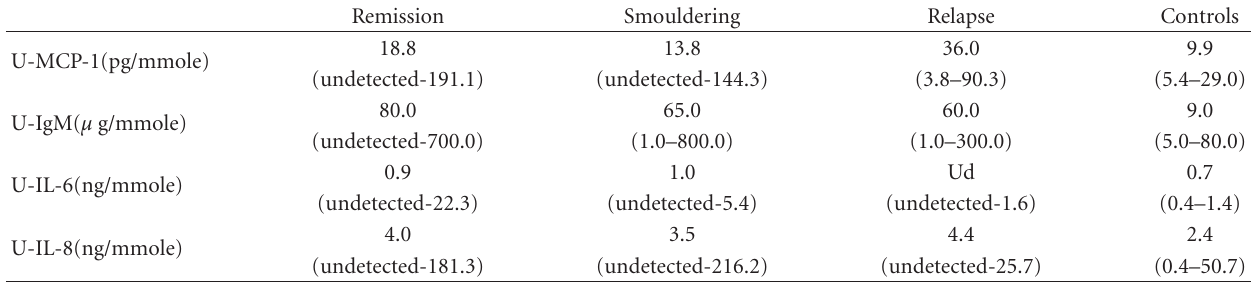
Table 3: Statistical plausibility of raised potential markers to be associated with outcome and relapse respectively. Severe outcome defined as critical damage, according to (vasculitis damage index